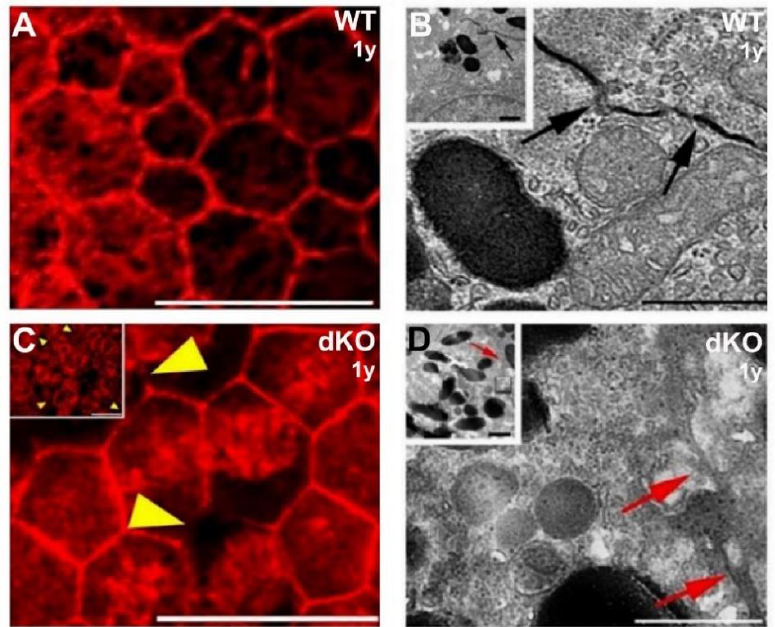
Figure 2. Structural changes of the apicolateral retinal pigment epithelium (RPE) cell–cell junctions in 1-year-old NFE2L2/PGC-1α dKO mice as compared with their wild-type (WT) counterparts. The pictures shown in ( A , C ) are from phalloidin-based immunofluorescent flat mount confocal microscopy, while transmission electron microscopy (TEM) images are presented in ( B , D ). Phalloidin was used to visualize filamentous actin rings on flat-mount samples and indirectly examine the cellular density and arrangement. The WT retinal epithelium consists of typical hexagonal cells ( A ), while dKO RPE cells are, by contrast, less regular in their outline. While cellular density can vary somewhat, regions of the WT RPE display higher cellular density. In 1-μm-thick confocal sections of phalloidin-labeled tissues, apical cell boundaries are marked by rings of actin filaments associated with intercellular junctions. Yellow arrowheads indicate multiple locations of the altered phalloidin staining for the apical aspect of the RPE complex. Inserts in ( B , D ) illustrate the RPE apicolateral zone and the high power TEM images show the profile of lateral RPE cell–cell contact (black ( B ) and red ( D ) arrows). Scale bars: 20 µm ( A , C ) and 1 µm ( B , D ).